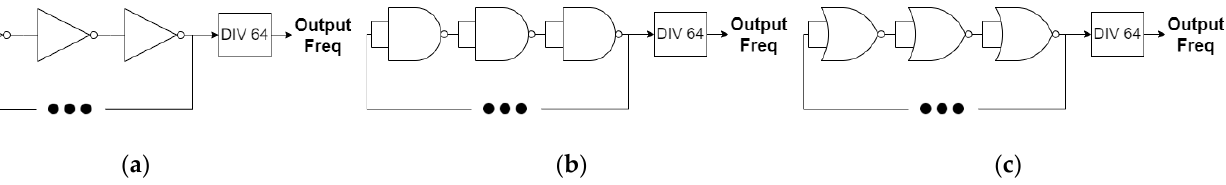
Figure 1. Three different RO designs: ( a ) Inverter-based RO design; ( b ) NAND2-based RO design; ( c ) NOR2-based RO design. Table 1. Inverter-based programmable RO simulation results. Delay Block